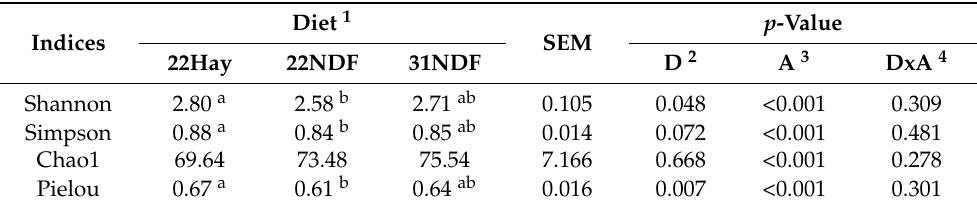
Figure 5. β -diversity of bacterial community in ruminal fluid samples in dairy calves fed different levels and sources of NDF. Multidimensional scaling (MDS) showing the weighted UniFrac distance metric; 22NDF—calves fed starter concentrate with 220 g NDF/kg; 22Hay—calves fed starter